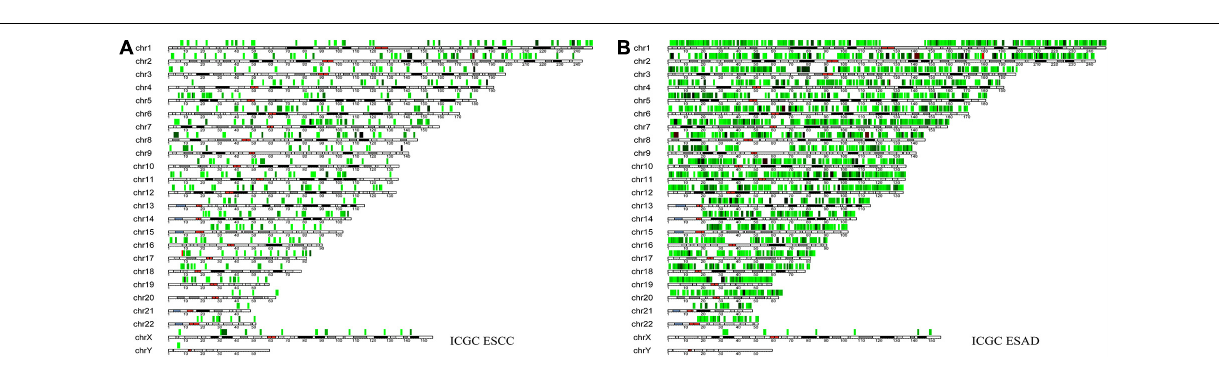
FIGURE 2 | The location of various somatic mutations in esophageal squamous cell carcinoma (A) and esophageal adenocarcinoma on chromosomes (B)